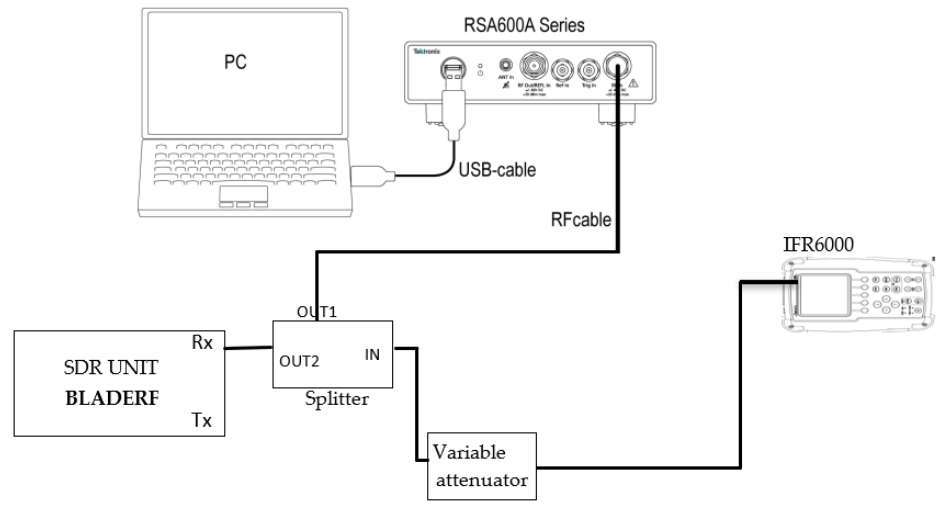
Figure 12. Sensitivity test bench block diagram.